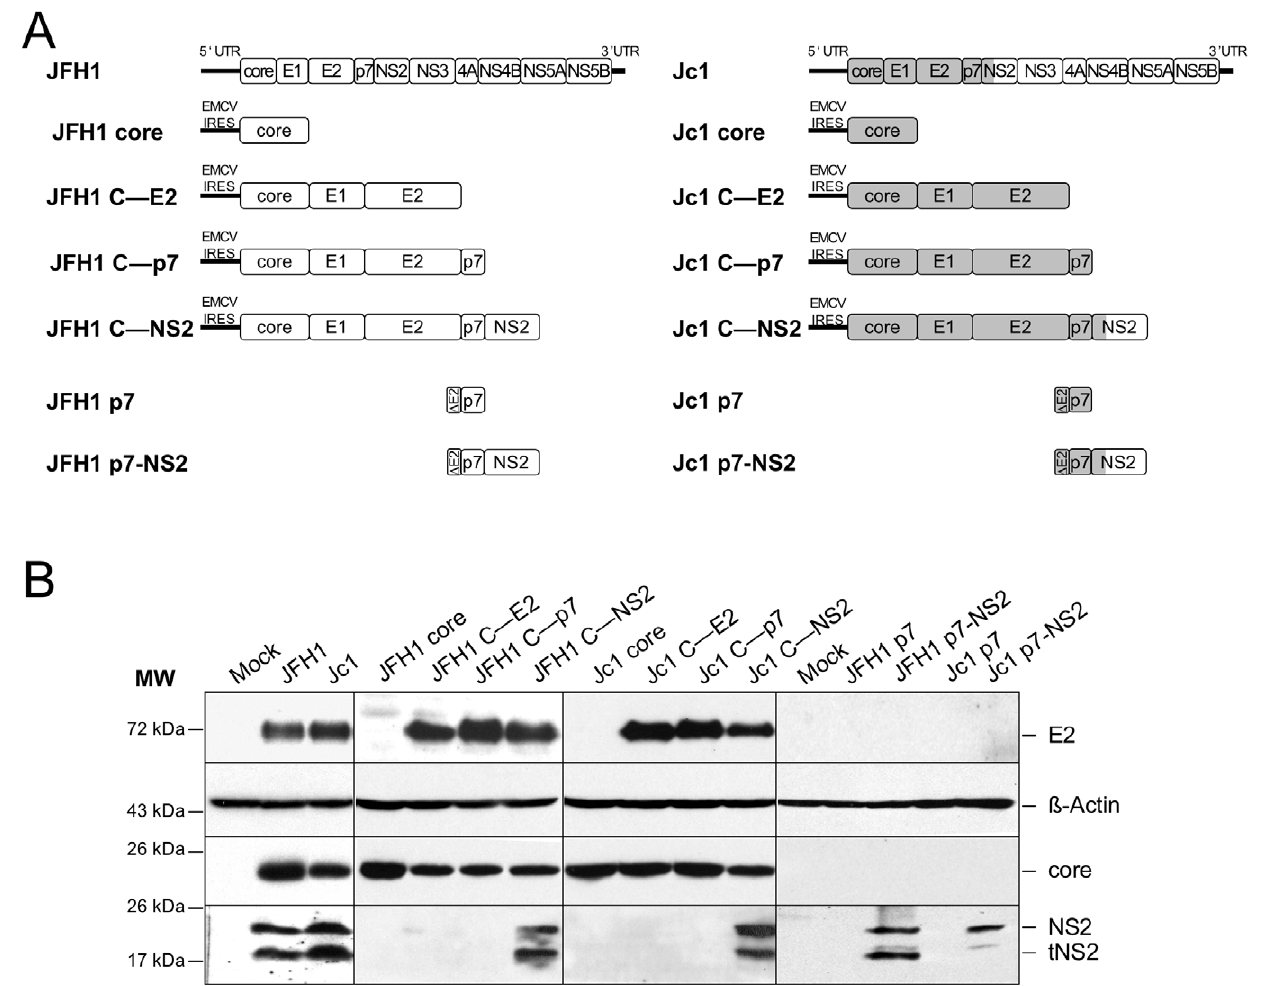
Figure 4. Plasmid constructs and expression levels of core and E2 proteins. Schematic diagrams of HCV protein-expression constructs used in this study ( A ). The sequences encoding core to the first TMS of NS2 derived from the J6-CF HCV isolate are indicated in gray boxes whereas sequences from JFH1 strain are shown in white boxes. Core, core-E1-E2 (C—E2), core-E1-E2-p7 (C—p7), core-E1-E2-p7-NS2 (C—NS2) (poly)proteins derived from JFH1 and J6-CF (Jc1) isolates were expressed using a CMV promoter expression construct. The p7 and p7-NS2 proteins were expressed using a signal peptide derived from the last 45 amino-acids of HCV E2 ( D E2) via transduction with MLV-based retroviral vectors. At 72 h post- transfection, lysates from mock-transfected cells, from JFH1 or Jc1 HCVcc-expressing cells, from Huh7.5 cells transfected with the JFH1 or Jc1 core, C—E2, C—p7 or C—NS2 expression constructs, or from Huh7.5 cells transduced with the MLV-based vectors expressing JFH1 or Jc1 p7 or p7-NS2, as indicated, were prepared and examined by Western blot analysis using antibodies against NS2, core and E2 proteins ( B ). The input of the samples was assessed by staining with an Actin antibody. blotting analysis demonstrated efficient expression and maturation